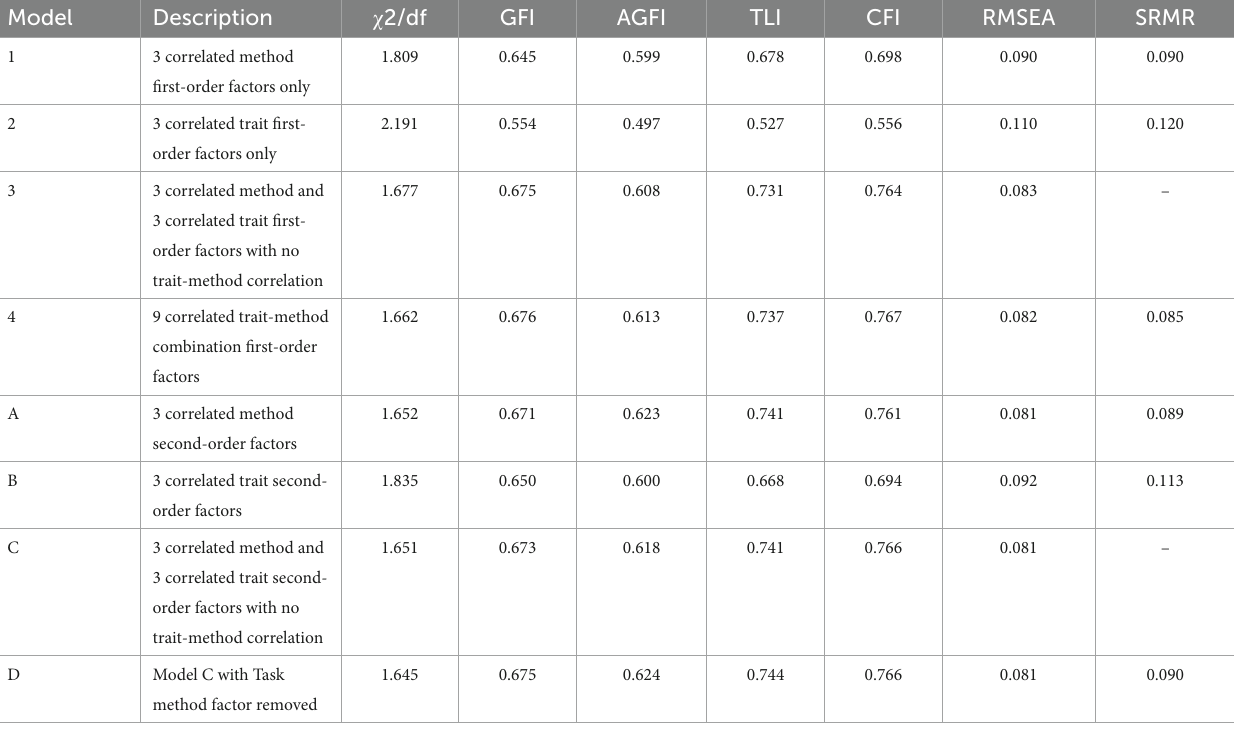
TABLE 4 Goodness-of-fit indexes of confirmatory factor analysis model.